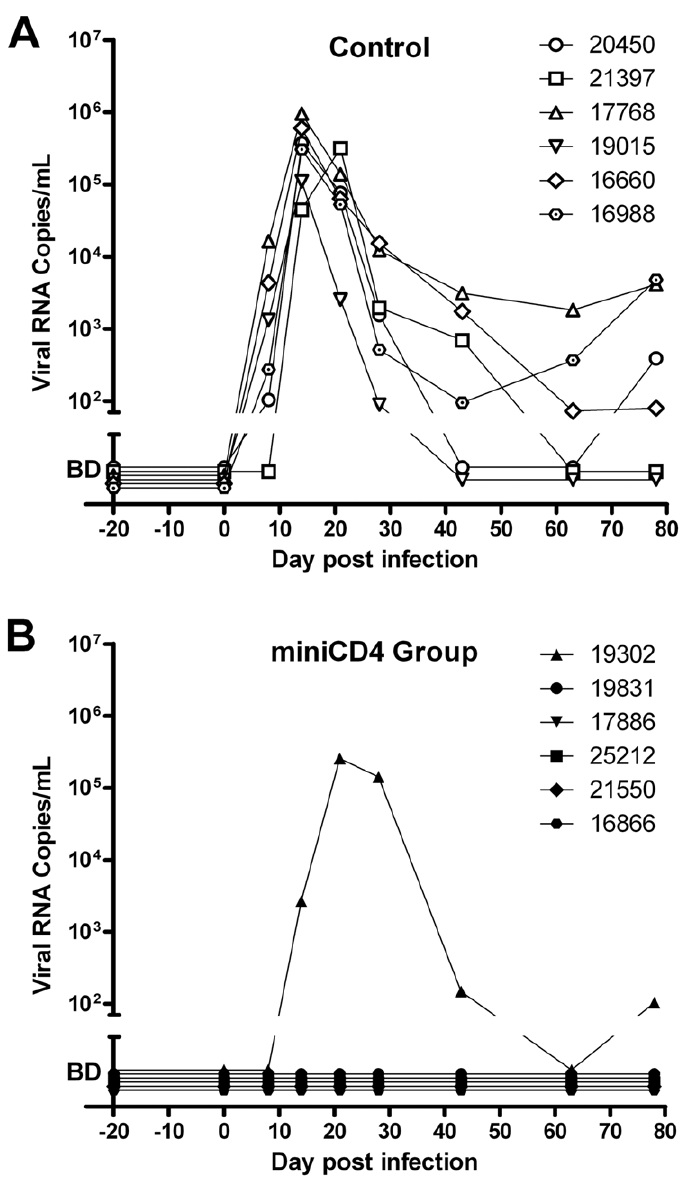
Figure 4. Protection of macaques against vaginal SHIV challenge by pretreatment with M48U1 gel. Viral loads in placebo ( A ) and M48U1-gel ( B ) treated macaques. One hour after gel application, animals were challenged with 10 AID 50 of SHIV 162P3 . Macaques were monitored regularly for plasma viremia for 78 days. The area below the ordinate axis break represents values below the 60 RNA copies/mL detection limit (BD – below